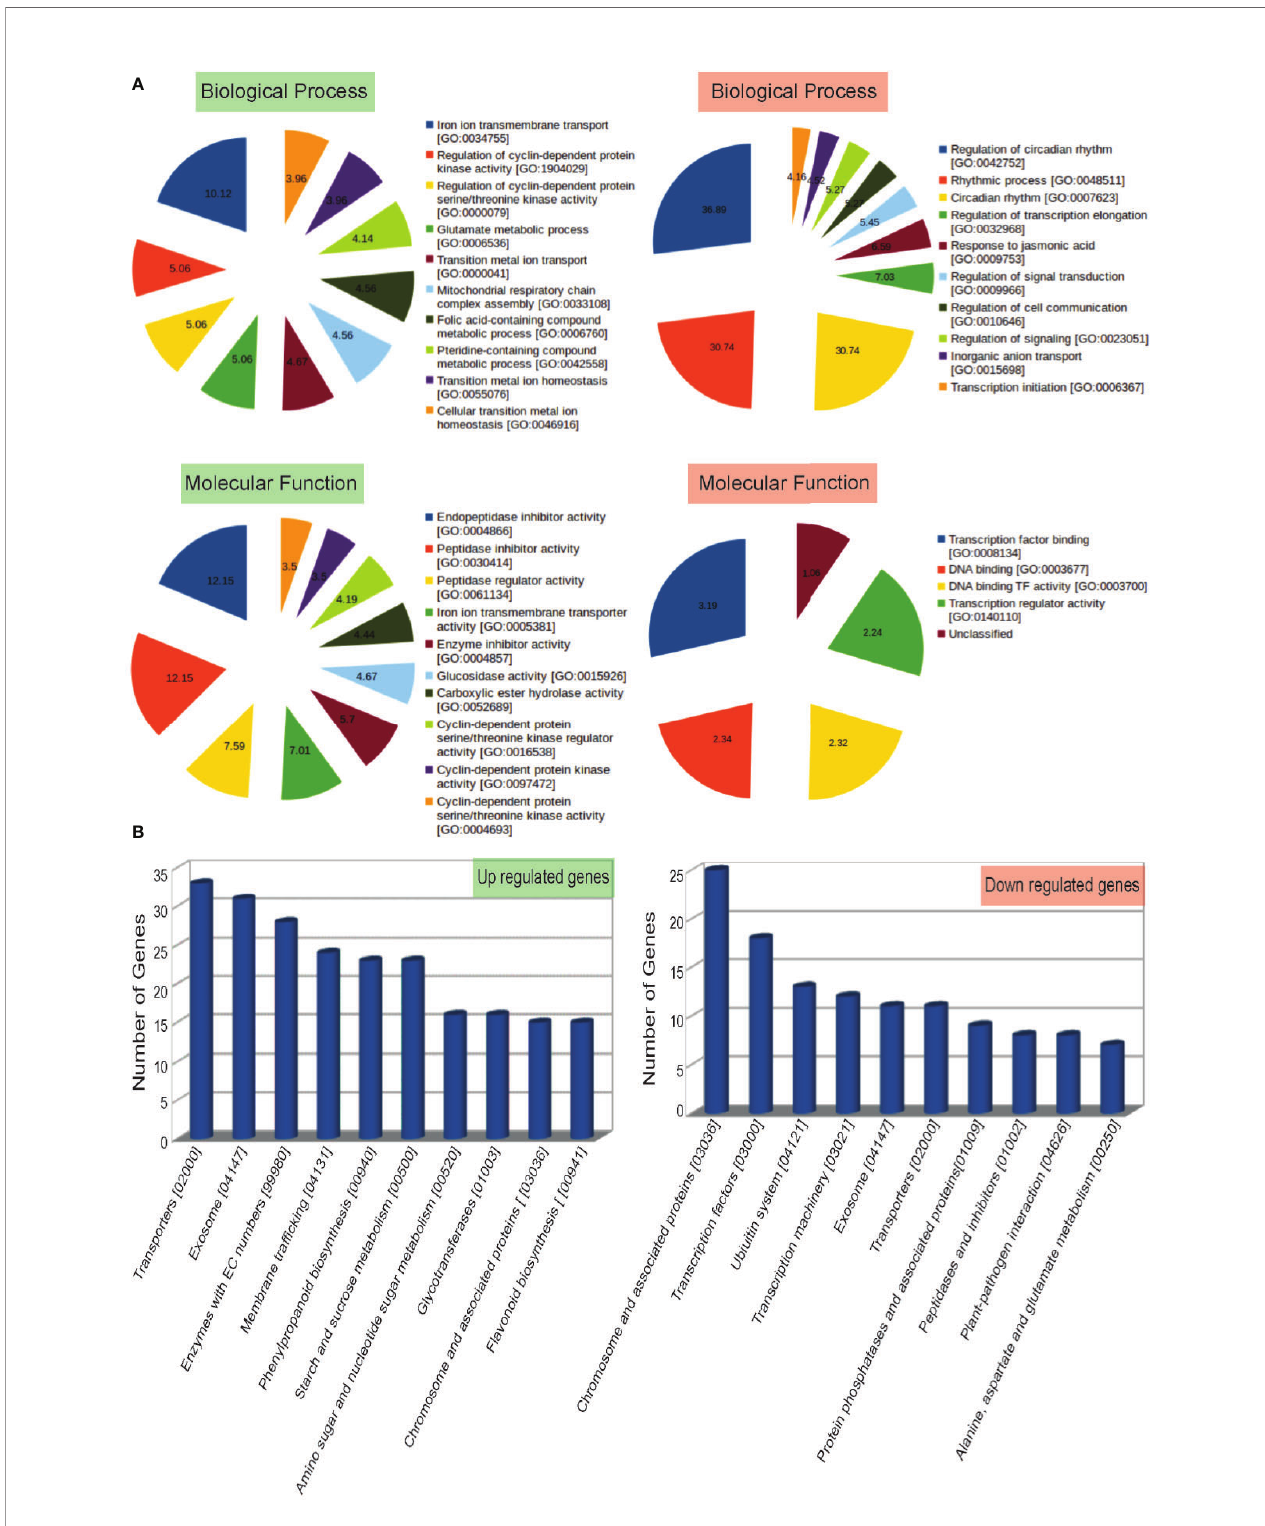
FIGURE 4 | (A) Top 10 Gene Ontology terms of Biological Process (BP) and Molecular Functions (MF) enriched in up (labeled in green) and downregulated (labeled in red) genes. Enriched BP and MF with p value < 0.05 and with an enrichment factor > 1 are shown. Numbers represent fold change enrichment value of a particular function in each dataset. (B) Graphical representation of up and downregulated pathways (X-axis) with number of genes identi fi ed in each pathway category plotted on the